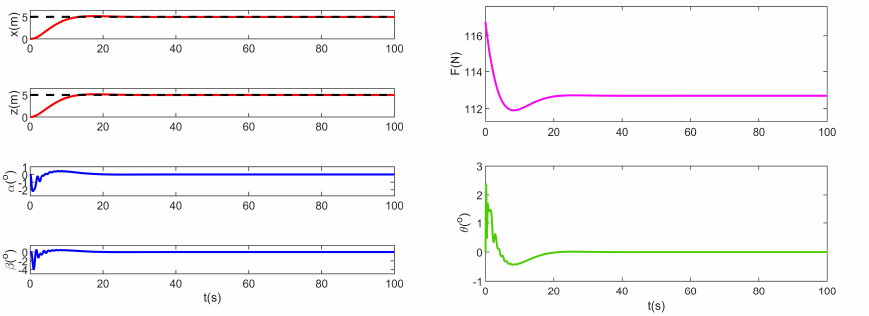
Figure 3. Simulations results for nonlinear control